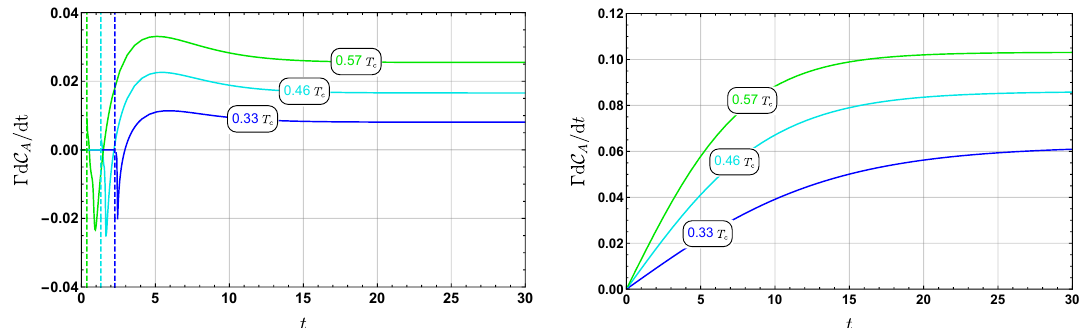
Figure 14 . The complexity growth rate of the superconducting phase for the positive critical time t c > 0 (left panel). As a comparison, the case for the normal phase at the same temperature is presented in the right panel. Here Γ = 16 π 2 G